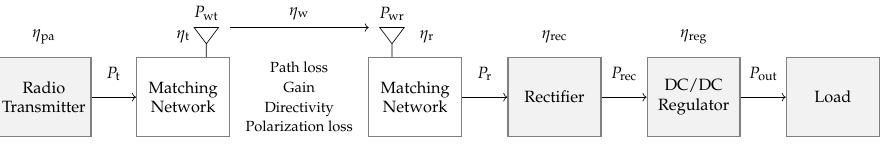
Figure 6. Transmission and efficiency model for RF power transfer